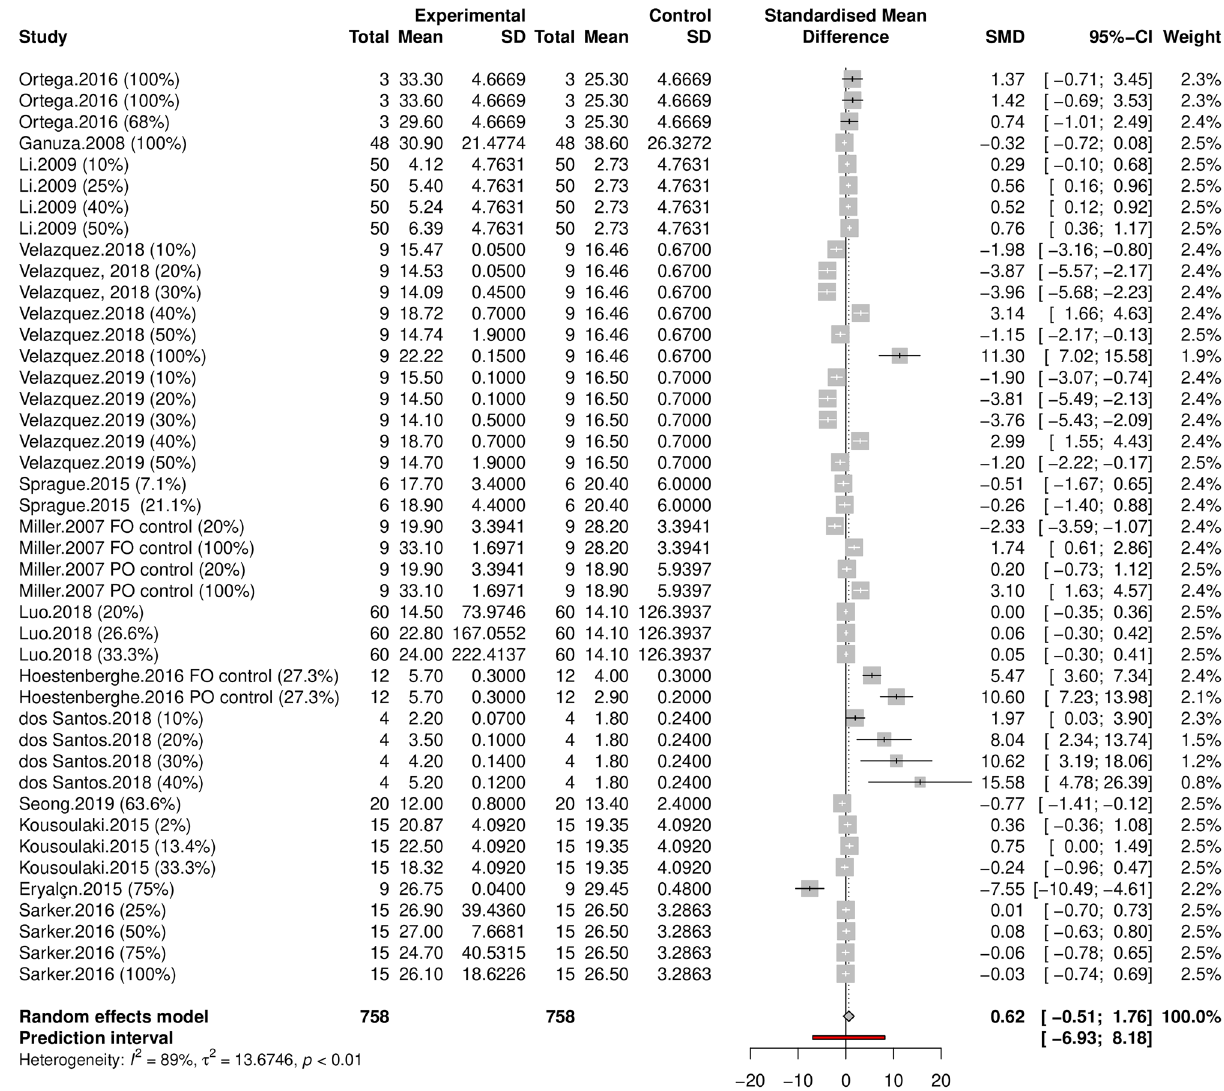
Figure 6. Forest plot summarizing the effect of Schizochytrium replacement on the omega-3 fillet content of farmed finfish. Each trial (n = 43) is represented by a square whose size is proportional to its relative weight, its width represents the 95% CI, the horizontal line the 99% CI, and the center the Standardized Mean Difference (SMD) corrected for small sample size (Hedge’s g ). The grey diamond at the bottom represents the overall effect extending over the 95% CI. The solid vertical line denotes the zero effect, and the dotted vertical line the SMD under a random effects